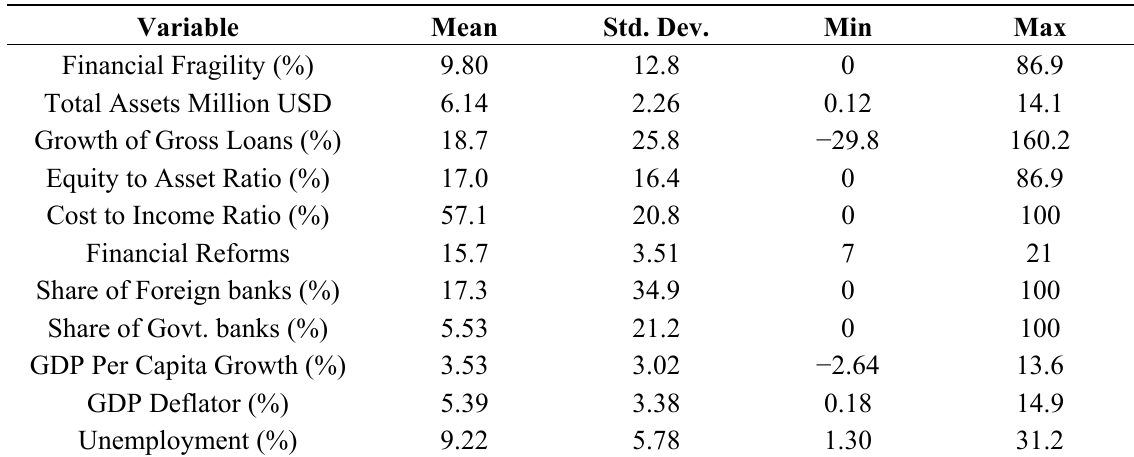
Table 2. Summary statistics of all